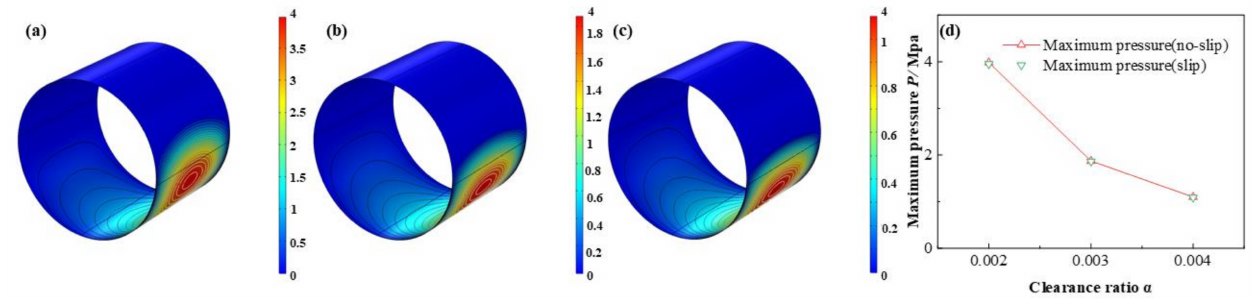
Figure 23. Comparison of the pressure distribution under different clearance ratios. ( a ) α = 0.002; ( b ) α = 0.003; ( c ) α = 0.004; ( d ) minimum pressure.